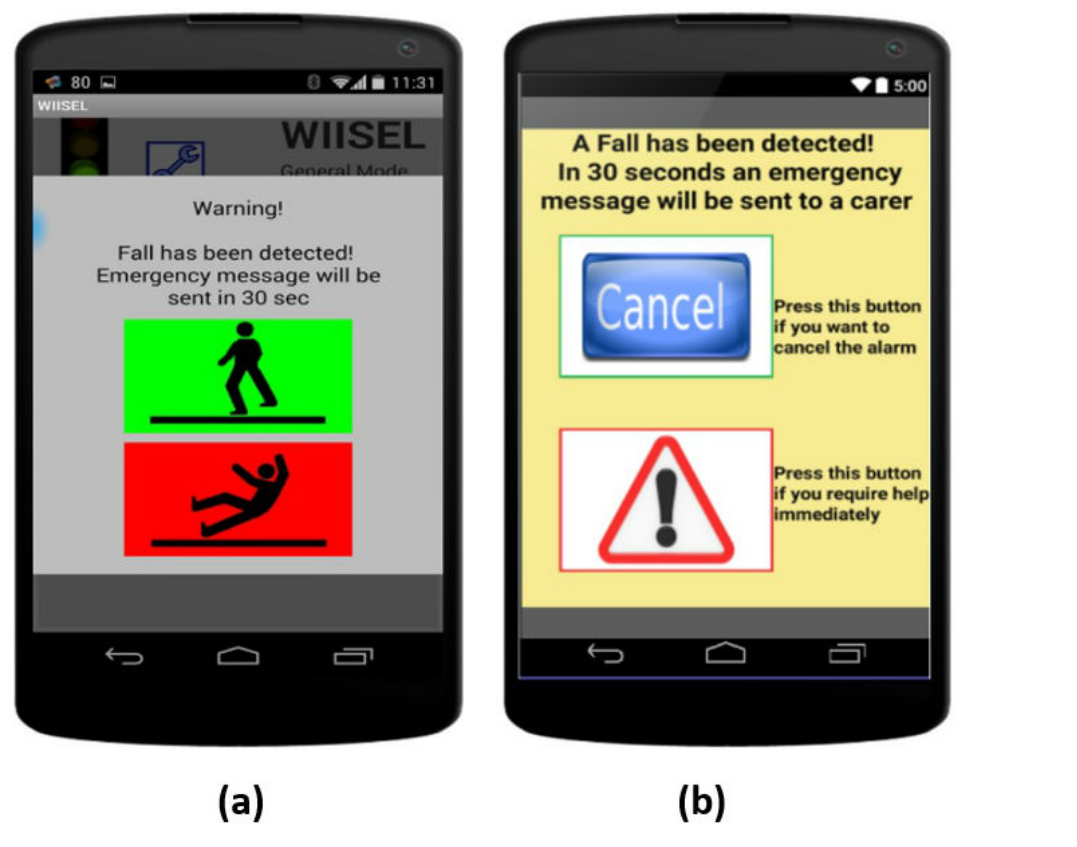
Figure 7. (a) Fall alarm interface before expert inspection, the red and green caused confusion as the red was associated with “cancel” as you would find on a phone call interface; (b) Fall alarm interface after expert inspection, a more appropriate symbol was introduced for the help button whereas the cancel button was changed to a more neutral blue with appropriate